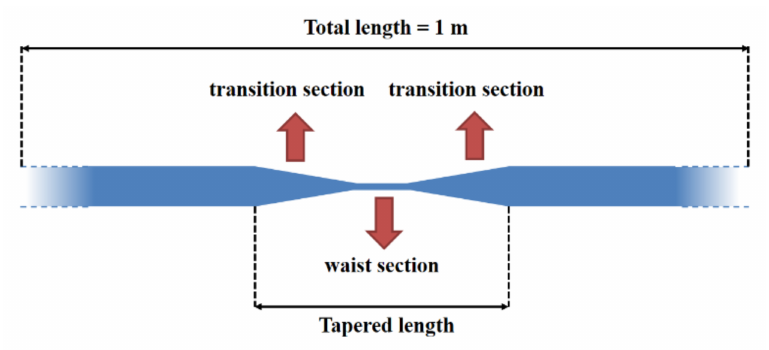
Figure 2. Structure of the bi-tapered